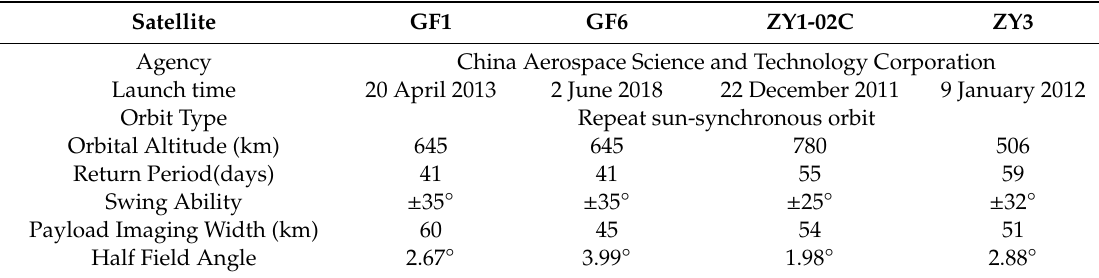
Table 1. Satellite and sensor parameters.